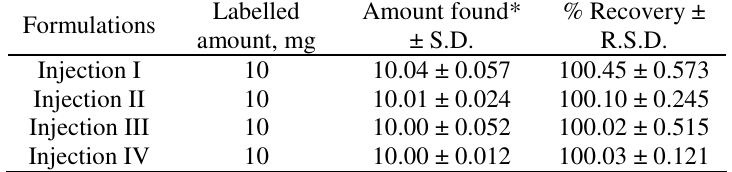
Table 4. Analysis of esmolol hydrochloride from pharmaceutical formulations by proposed